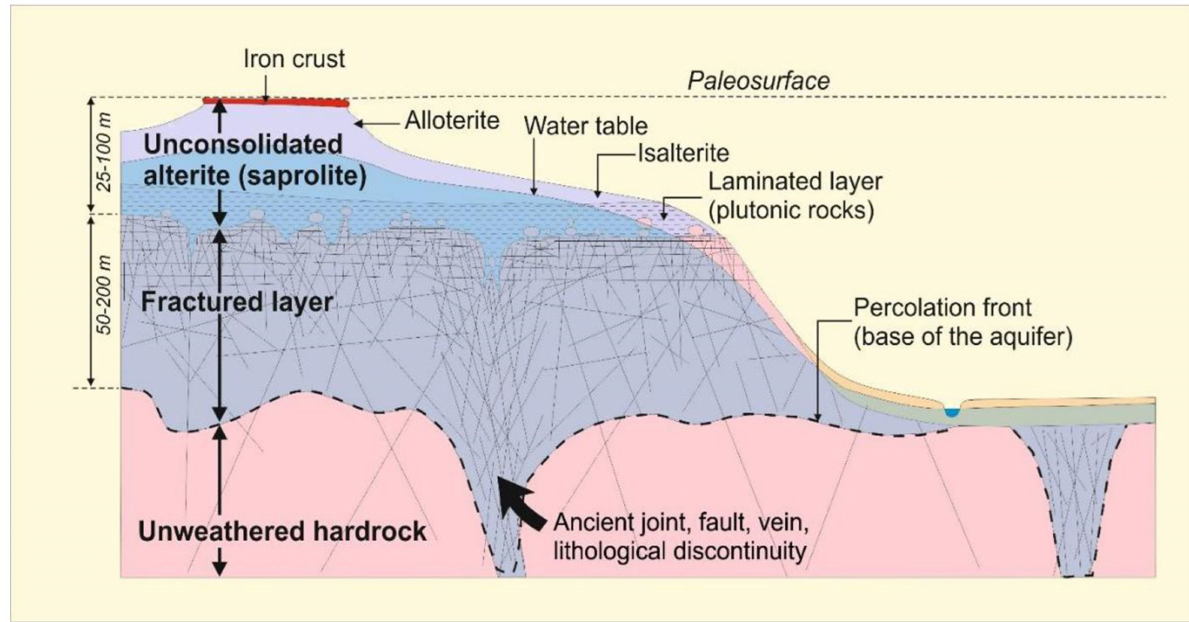
Figure 1. Conceptual model of a partly eroded paleo-weathering profile in hard rocks